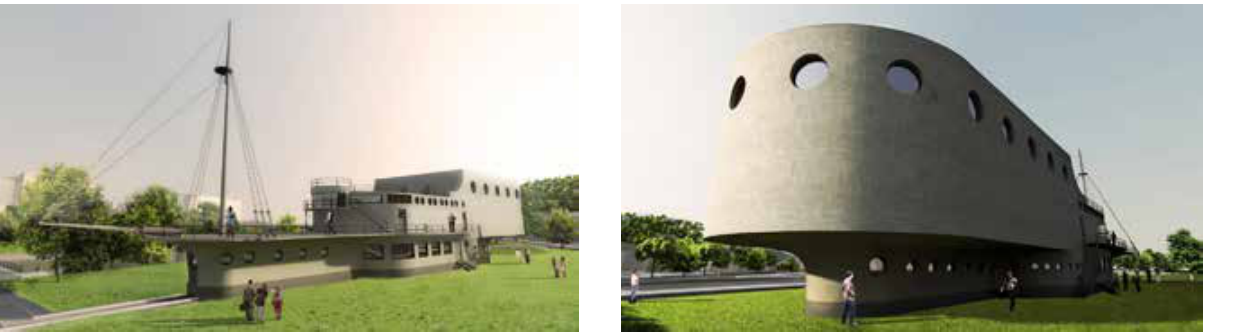
Figure 9. Photorealistic rendering of the 'Casa del Marinaretto'. Modeling and rendering by F. Carota.